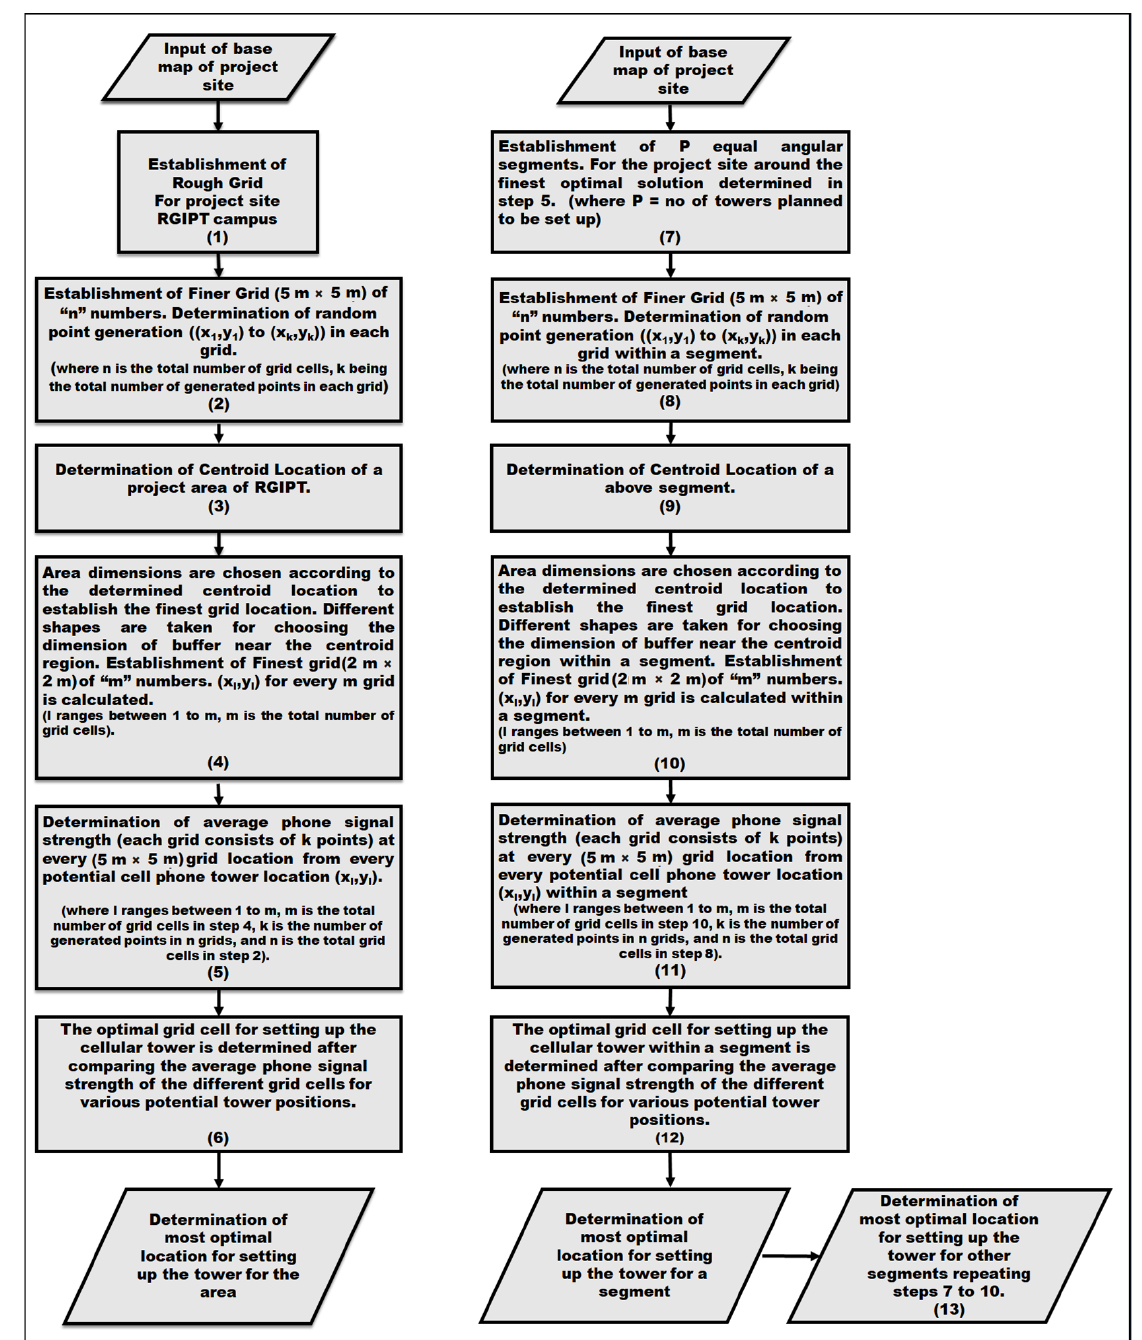
Figure 6. Model for the determination of optimal location(s) for setting up a cell phone tower(s). Cell phone tower location is also determined for the case where the population ratio is non-uniform. For that case, population density is considered, which area needs a higher value of signal strength. In some cases, where the population is non-uniform and the optimal location is found that is providing moderate signal strength to the high population part as well as low population part, then a shift in the cell phone tower location to improve the signal strength for the high population part will be